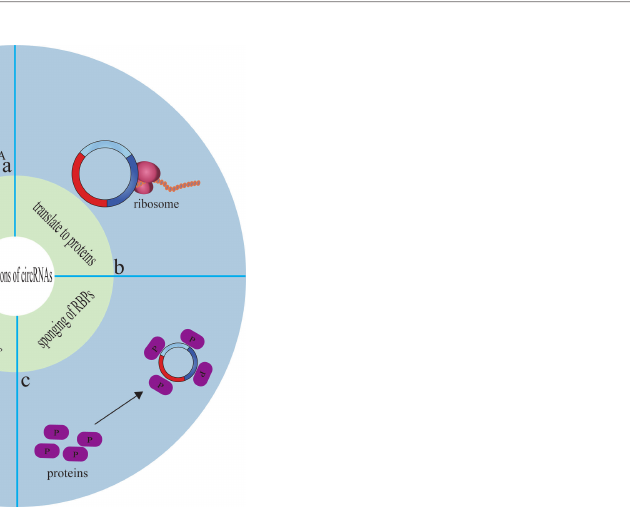
FIGURE 4 | Functions of circRNAs. (A) circRNAs competitively bind miRNAs, so as to serve as intracellular competitive endogenous RNA, suppressing the effects of miRNAs on target genes. (B) circRNAs can translate to proteins through a cap-independent manner. (C) circRNAs serve as protein baits or antagonists, thus arrestting the function of proteins, thereby affecting the related progresses. (D) circRNA function as a reservoir or a stabilizing factor for the